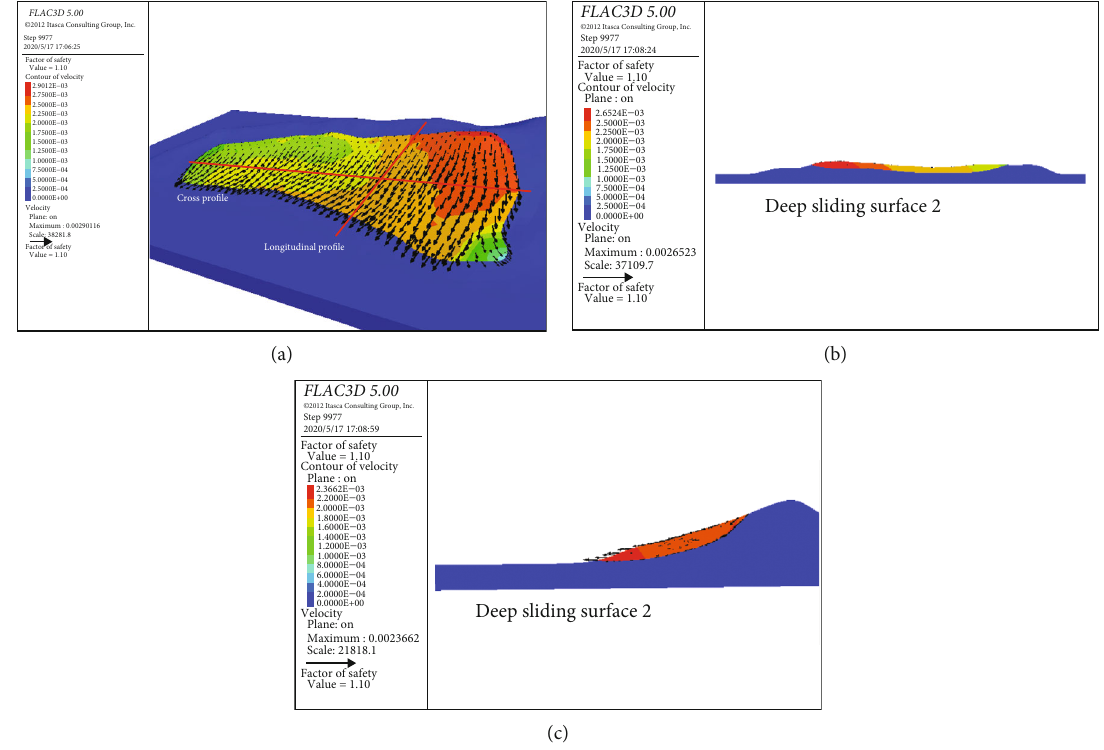
Figure 12: (a) Stability calculation results of deep sliding surface 2 (I-IV) under seismic conditions. (b) Stability calculation results of deep sliding surface 2 (I-IV) under seismic conditions (crosspro fi le). (c) Stability calculation results of deep sliding surface 2 (I-IV) under seismic conditions (longitudinal pro fi